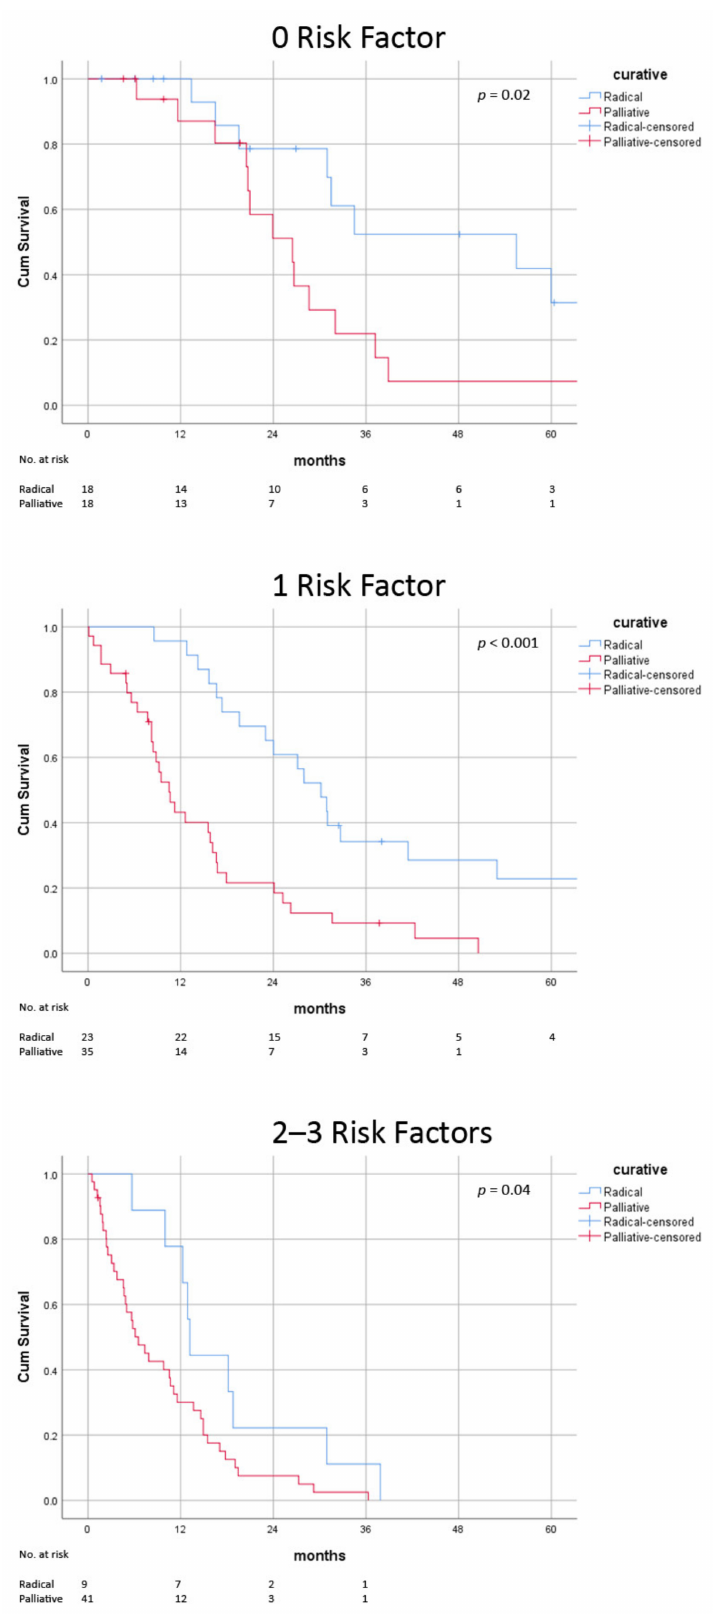
Figure 5. Post-recurrence survival of radical versus palliative treatment stratified by number of risk